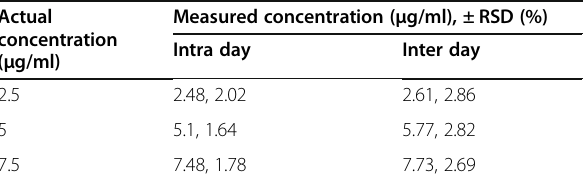
Table 5 Intra and inter assay precision data ( n = 6) Actual concentration